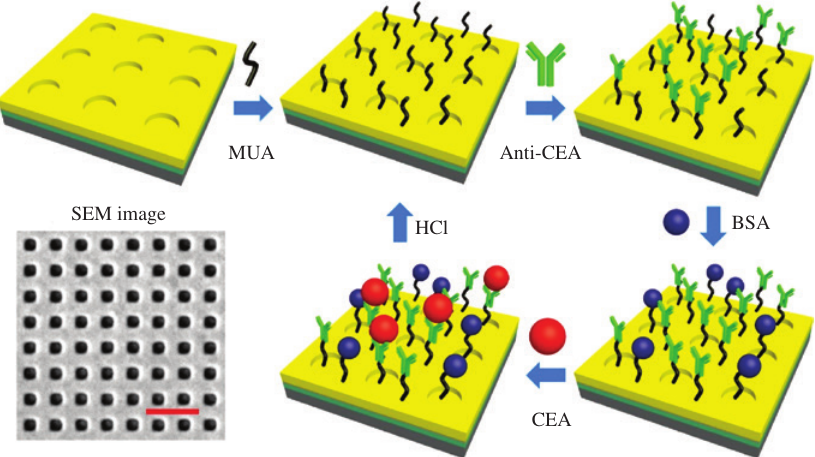
Figure 2: Schematic drawing of functionalization, detection, and recycling for the PNA surface. The SEM image of the PNA surface is provided in the left corner, with the red scale bar of 1 μ m. (The schematic drawing does not represent the precise sizes of the adsorbed materials compared with the dimensions of